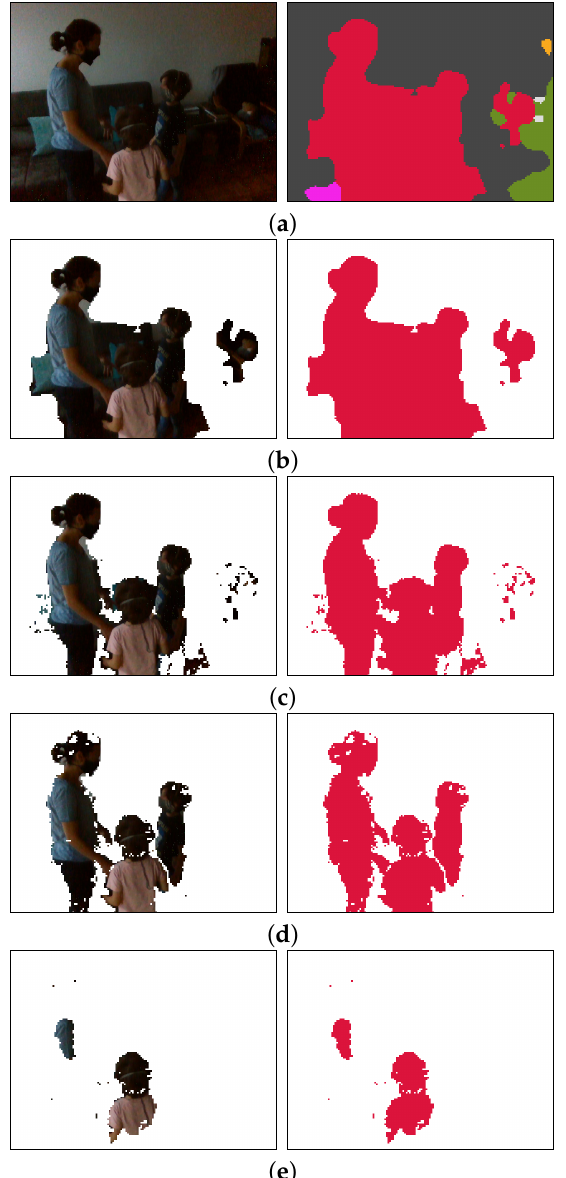
Figure 6. Image post-processing steps. ( a ) Source image from the color camera ( left ) and its semantic segmentation ( right ); ( b ) pixels not labeled as persons are filtered out; ( c ) pixels beyond 1.5 m are filtered out; ( d ) pixels closer than 5 m are filtered out. This includes pixels whose depth value cannot be calculated (reported distance 0 m); ( e ) Of the remaining pixels, only the 25% closest to the camera are retained, which are the pixels that contribute to the